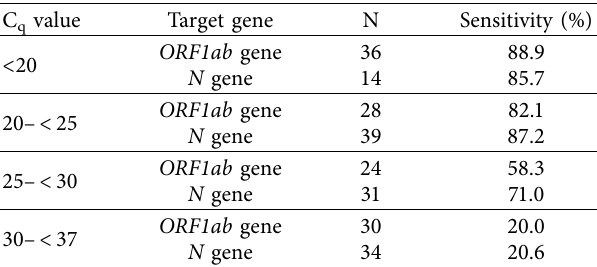
Table 5: Sensitivity of rapid antigen test in each Cq values stratified